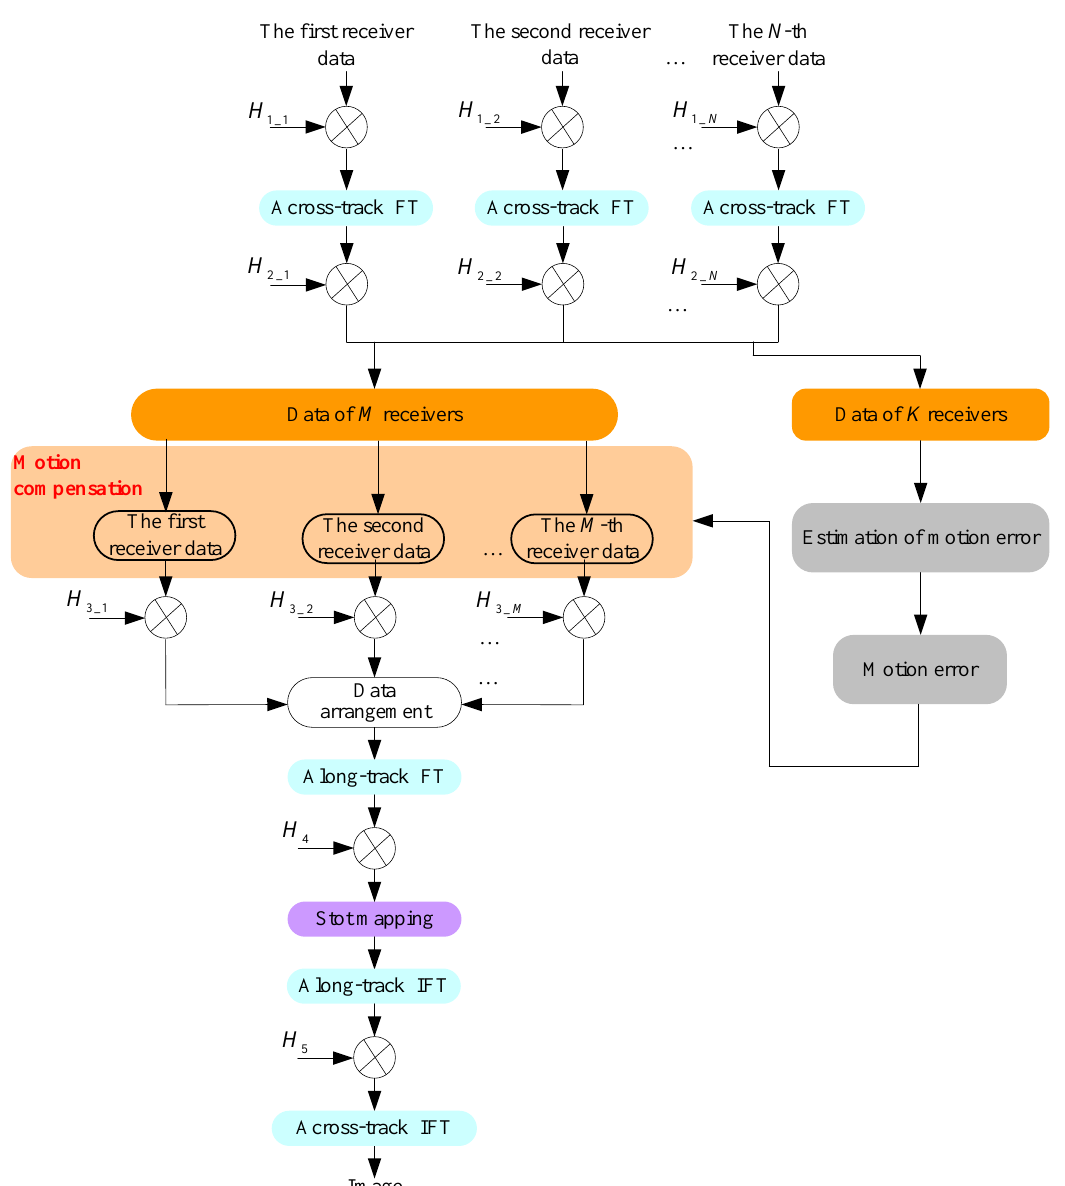
Figure 18. Block diagram of the presented method. FT = Fourier transformation; IFT = inverse Fourier transformation.